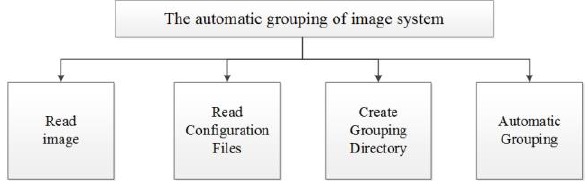
Figure 3. The main functions of the system